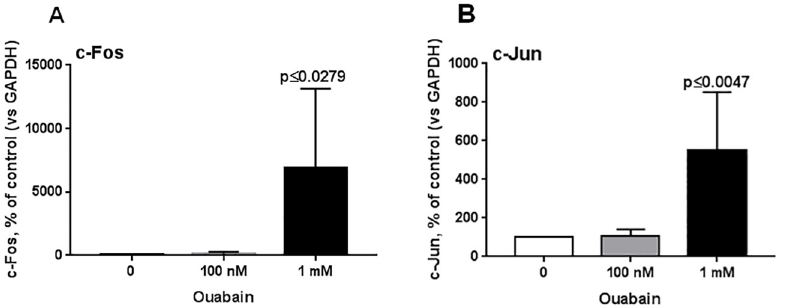
Fig 5. Expression of c-Fos (A) and c-Jun (B) mRNAs in cerebellum granule cells after 3 h of incubation with 100 nM or 1 mM ouabain. Data obtained in 5 independent experiments are presented as the mean ± SD. Gene expression in the absence of ouabain was taken as